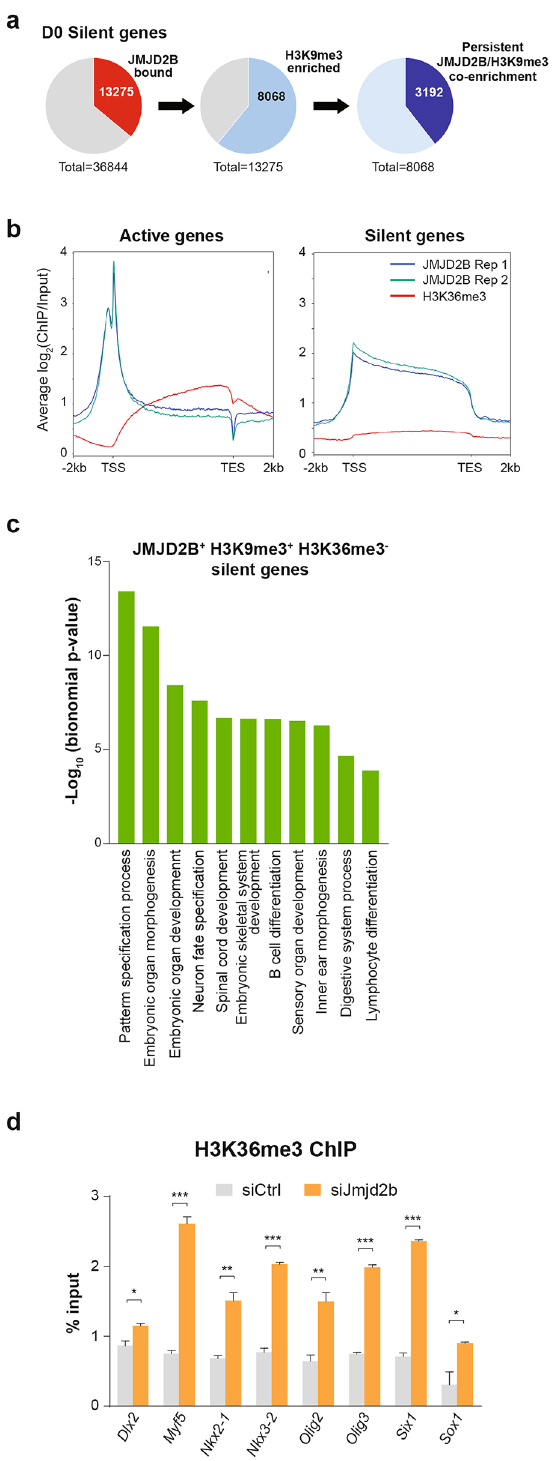
Figure 4. JMJD2B represses non-trophoblast genes through H3K36me3 demethylation. ( a ) Pie charts showing co-enrichment of JMJD2B and H3K9me3 in a subset of silent genes (8,068) in undifferentiated TSCs. 3,192 of these co-enriched genes show persistent patterns throughout TSC differentiation (from D0 to D6). ( b ) The average ChIP-seq signal patterns of JMJD2B and H3K36me3 in undifferentiated TSCs. TSS transcriptional start site, TES transcriptional end site. ( c ) GO analysis of the biological processes for the JMJD2B + H3K9me3 + H3K36me3 - silent genes in undifferentiated TSCs. ( d ) ChIP-qPCR showing significant increase in gene body H3K36me3 enrichment at a panel of H3K9me3-associated embryonic lineage genes in the Jmjd2b knockdown TSCs when compared to that of the control sample. The qPCR primers were designed at the gene bodies based on H3K36me3 ChIP-seq signal. Three independent experiments were performed. Data represent mean ± SD; Student’s t-test * P < 0.05, ** P < 0.01, and *** P <